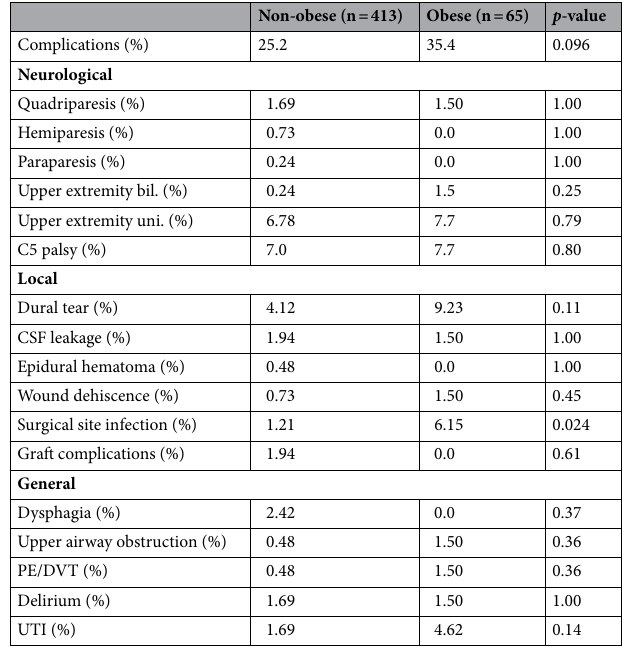
Table 3. Perioperative complications in non-obese and obese groups. Non-obese: BMI < 30.0 kg/m 2 ; Obese: BMI ≥ 30.0 kg/m 2 ; BMI: body mass index; bil: bilateral; uni: unilateral; CSF: cerebrospinal fluid; PE: pulmonary